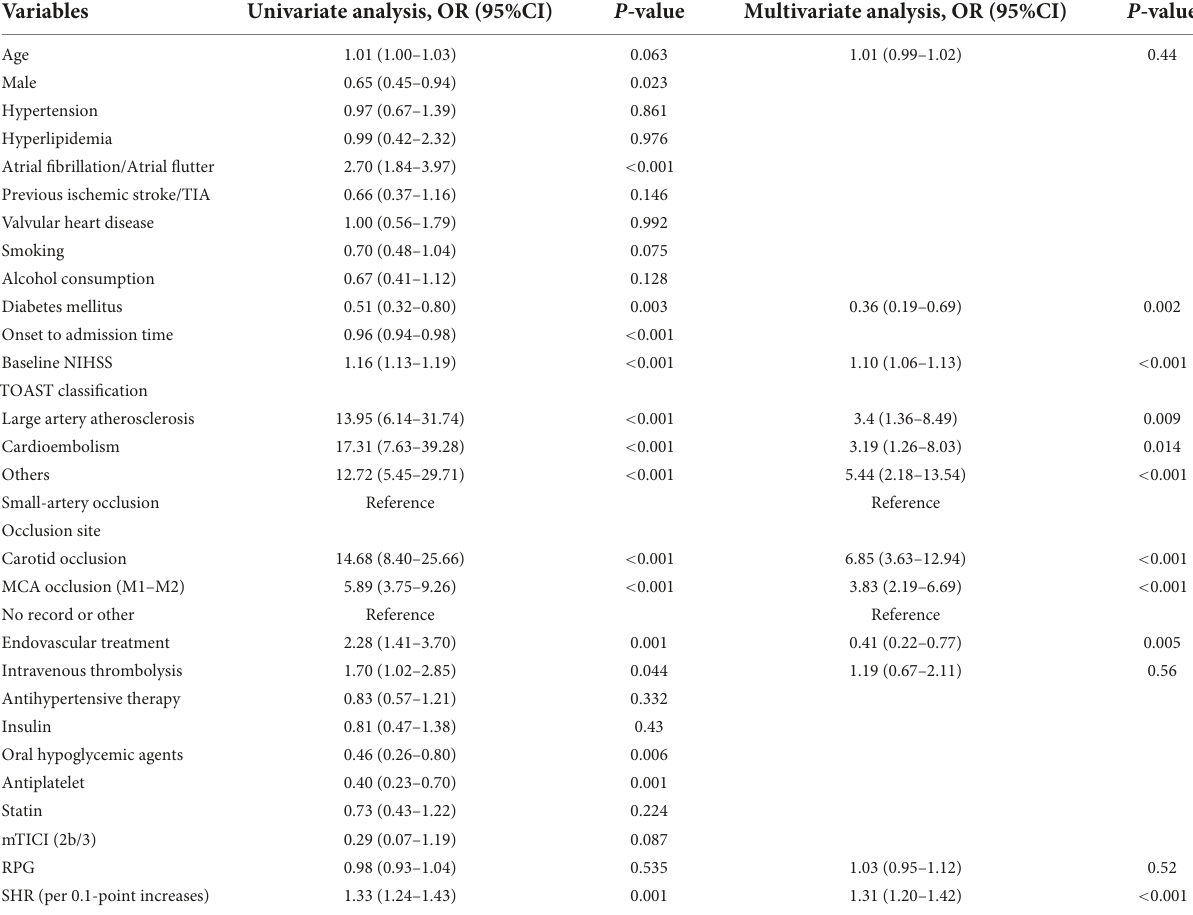
TABLE 2 Associated factors for the development of CED on training